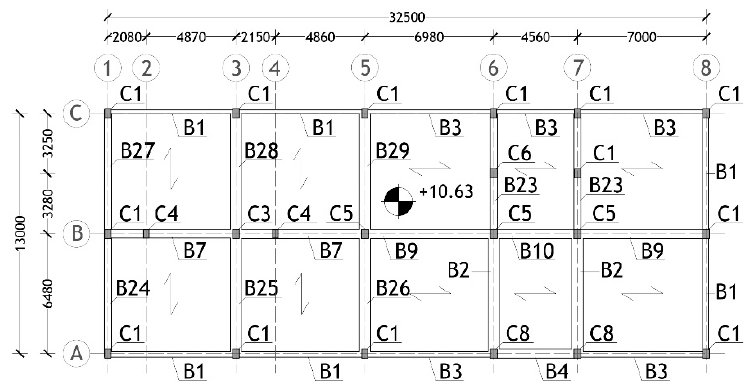
Figure 4. Third floor structural plan.